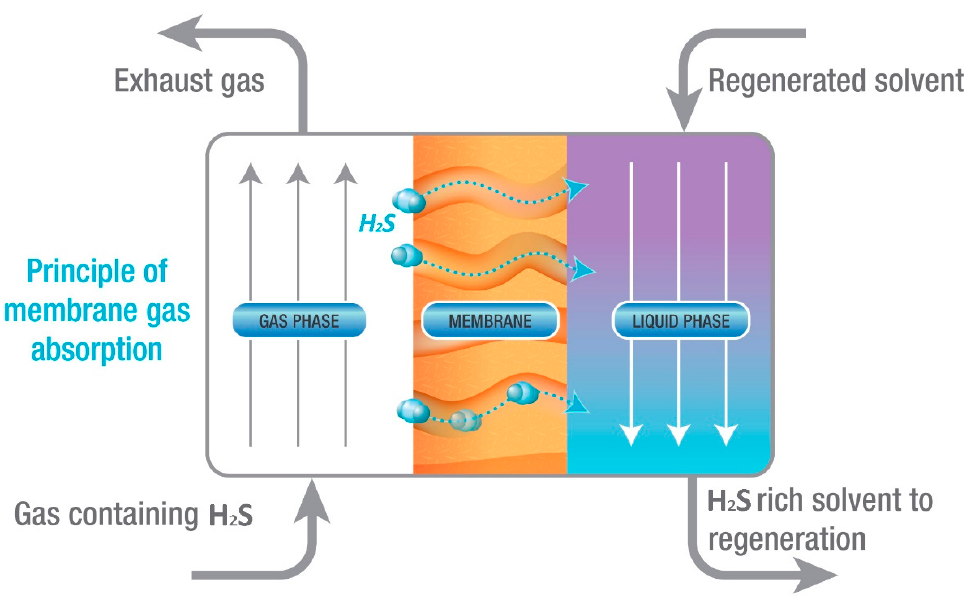
Figure 5. Operation principle of an MGA H 2 S removal system (adapted from [43]).